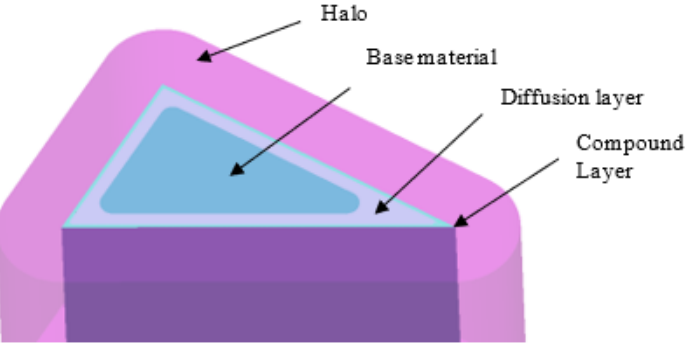
Figure 1. Illustration of the edge effect mechanism.